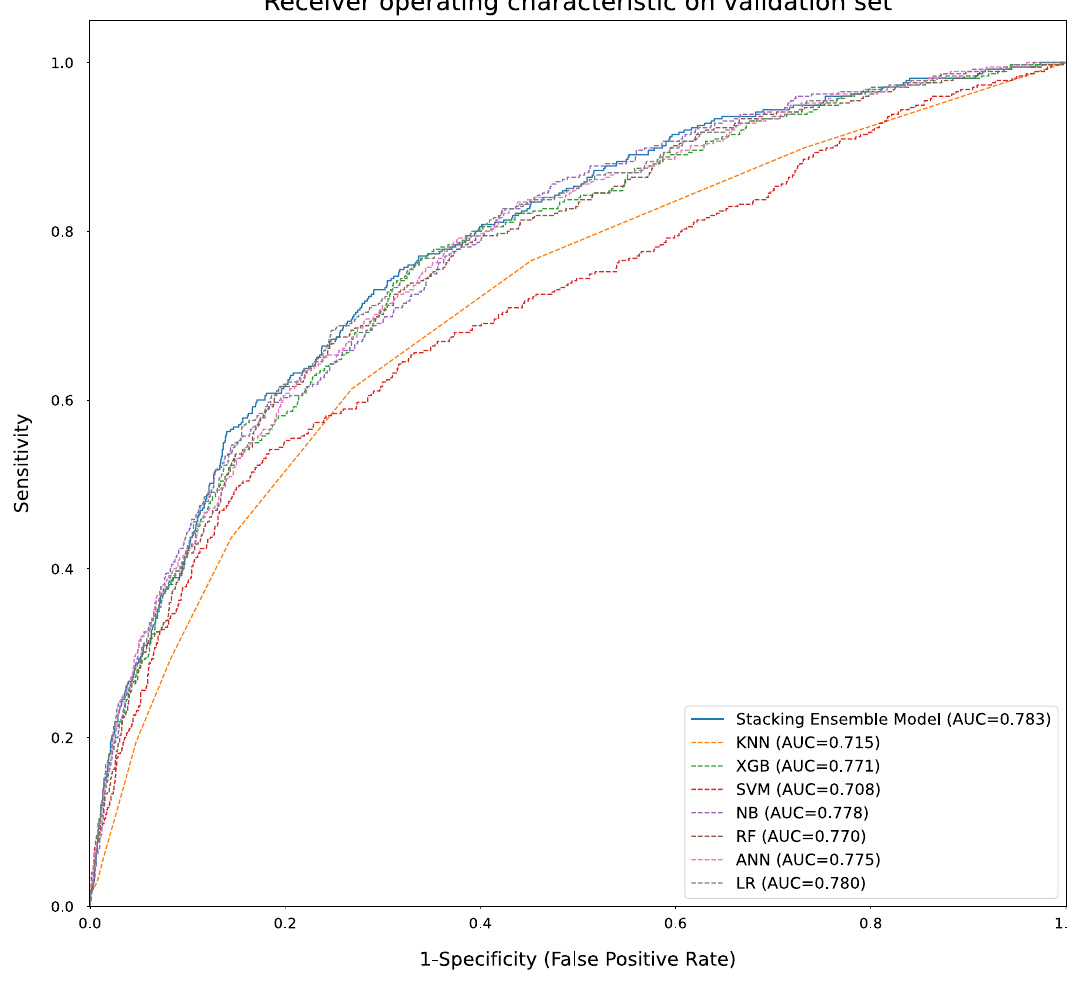
Figure 3. Receiver operating characteristics curve for seven base and ensemble learners. KNN: k-nearest neighbors; XGB: extreme gradient boost; SVM: support vector machine; NB: Naïve Bayes; RF: random forests; ANN: artificial neural networks, LR = logistic